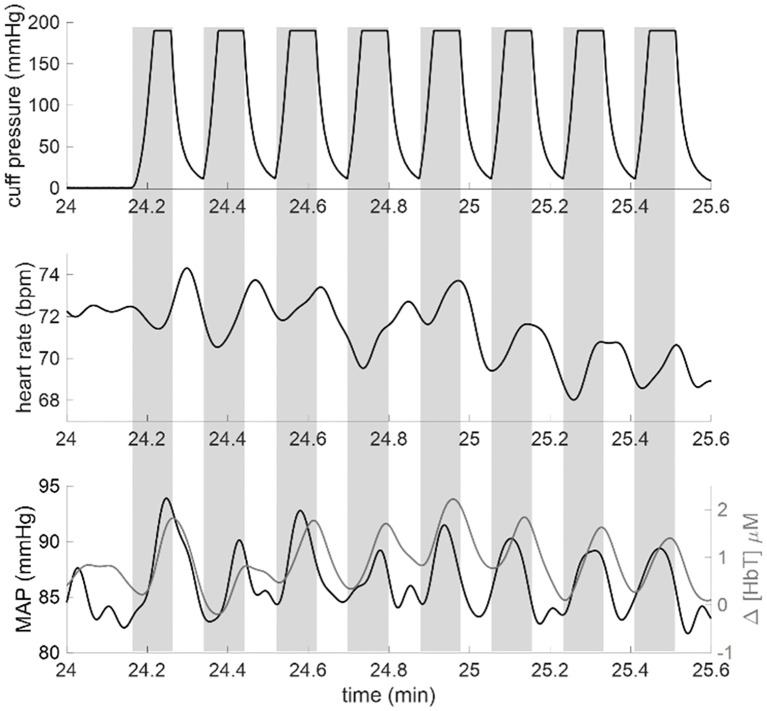
Example time traces of induced oscillations from Subject 5.Gray rectangles indicate the cuff inflation periods (from start of inflation to start of deflation). Top panel: Thigh cuff pressure measured with the manometer. Thigh cuffs were inflated for 11 seconds and deflated for 11 seconds to induce hemodynamic oscillations at a frequency of 0.093 Hz. Middle panel: Heart rate measured with the pulse oximeter in units of beats per minute (bpm). Bottom panel: mean arterial pressure (MAP) (black line) and total hemoglobin concentration changes (Δ[HbT], gray line). Signals in the middle panel and bottom panel have been low-pass filtered with a cut-off frequency of 0.25 Hz to suppress high-frequency noise and heart rate pulsations.